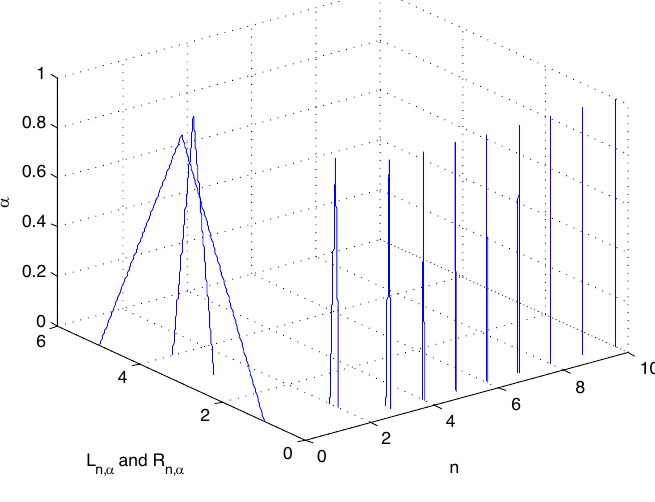
Figure 4: The dynamics of system ( 42 ) .